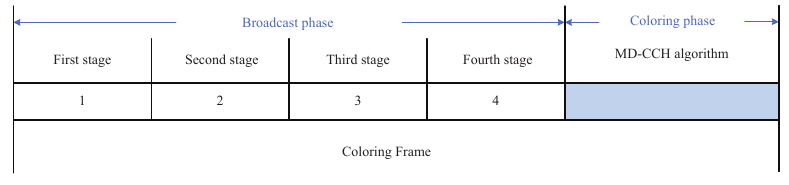
Figure 9. The coloring frame